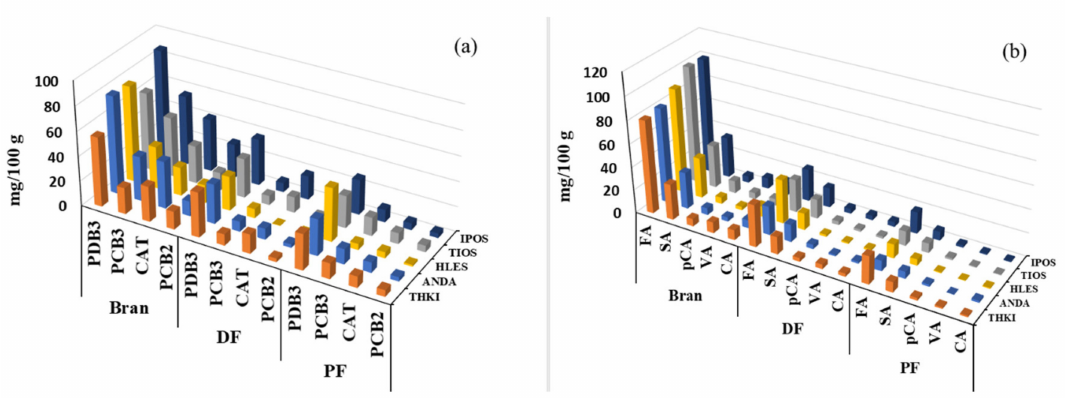
Figure 3. Individual flavanols ( a ) and phenolic acids ( b ) of fractions of selected barley cultivars. THKI, thessaloniki; ANDA, andromeda; TIOS, triptolemos; IPOS, ippolytos; HLES, hull-less; PDB3, prodelphinidin B3; PCB3, procyanidin B3; PCB2, procyanidin B2; CAT, catechin; FA, ferulic acid; SA, sinapic acid; pCA, p-coumaric acid; VA, vanillic acid; CA, ca ff eic acid; DF, dehulled flour; PF, pearled